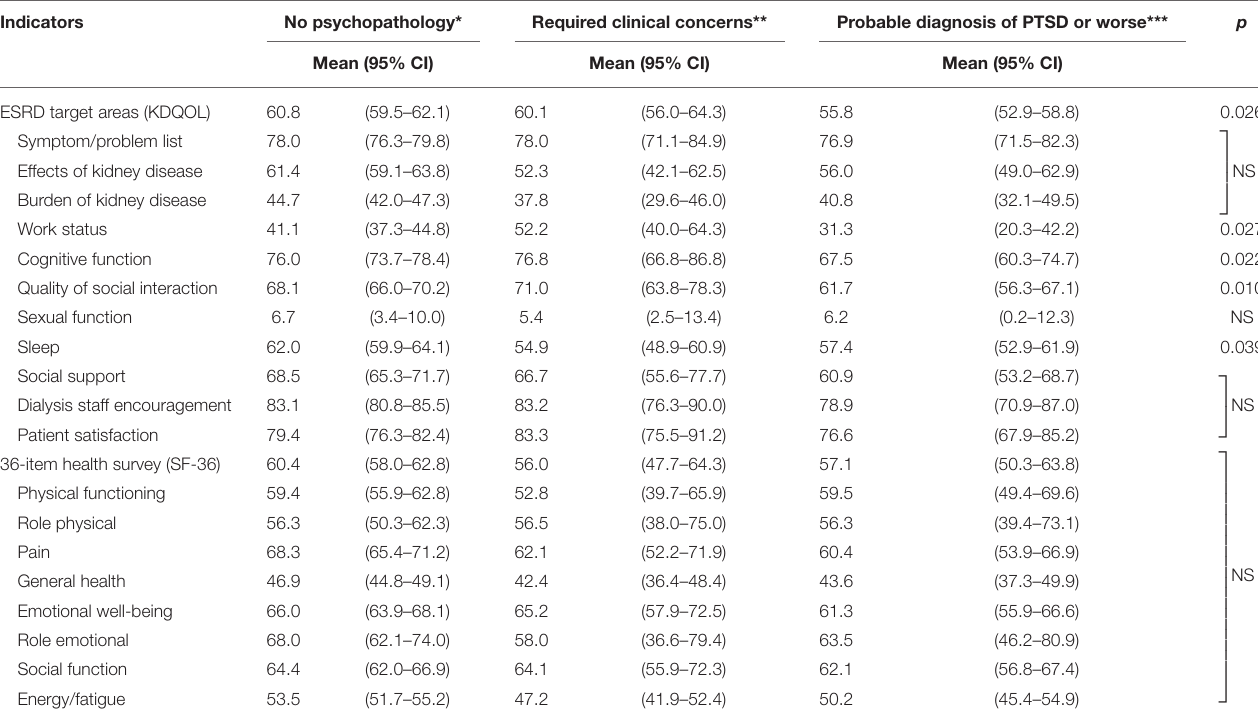
TABLE 3 | Effects of acute stress on quality of life of the patients during ongoing COVID-19 pandemic.